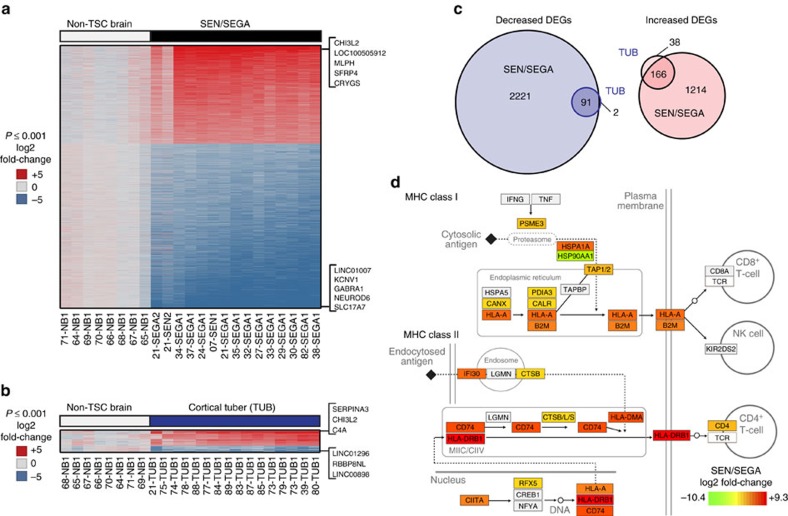
Shared gene expression features of TSC-associated brain lesions.(a,b) Genes differentially expressed in SEN/SEGA (a) or cortical tubers (TUB) (b) compared to non-TSC brain (NB) samples (log2 fold-change +/− >2; adjusted P<0.001) are coloured by log2-transformed fold-changes according to the scale (blue: low; red: high). Top 5 and top 3 increased and decreased DEGs are indicated for SEGAs (a) and cortical tubers (b), respectively. (c) Venn diagrams showing similarity in DEGs between TUB and SEGA (blue: decreased DEGs; red: increased DEGs). Circles are sized according to DEG number. (d) Molecular map of antigen processing and presentation modified from KEGG ID hsa04612. Genes are coloured according to log2 fold-changes in SEN/SEGA according to the legend.